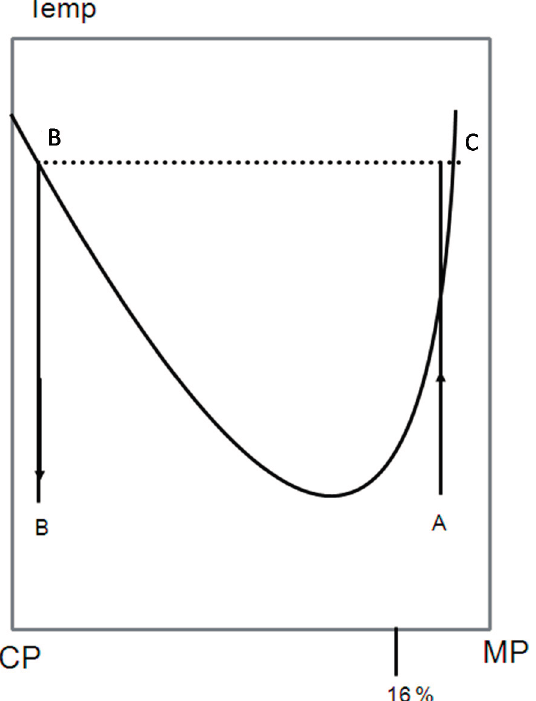
Figure 2. Schematic phase diagram with a lower critical solution temperature presented to illustrate double percolation. A, initial miscible composition; B, phase separated composition with high CP concentration; C, phase separated composition with low CP